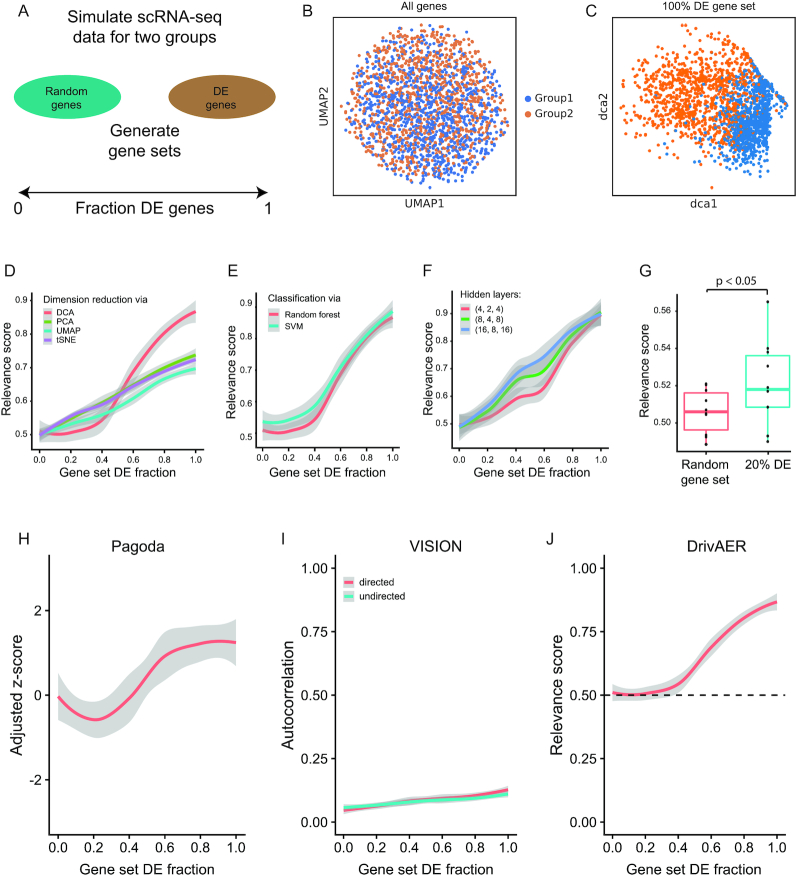
DrivAER identifies drivers underlying subtle transcriptional changes. (A) Two groups of single cells were simulated and gene sets were created by sampling a mixture of truly differentially expressed (DE) genes and random genes. (B) The global embedding using all genes is visualized using UMAP. (C) The DCA embedding for a gene set consisting of all truly DE genes is depicted. For both (B) and (C), cells are colored by group. (D) Relevance scores (y-axis) for gene sets ranging in the fraction of truly DE genes (x-axis) are displayed across implementations of DrivAER differing in the underlying dimension reduction methods. (E) Relevance scores (y-axis) for gene sets ranging in the fraction of truly DE genes (x-axis) are displayed using random forest (red) and support vector machine (SVM; blue) classification models. (F) Relevance scores (y-axis) for gene sets ranging in the fraction of truly DE genes (x-axis) are displayed across various configurations of the hidden layer. (G) Box plot shows significantly different relevance scores between 10 bootstrap runs of completely random gene sets (red) and gene sets consisting of 20% truly DE genes (blue) (1-sided t-test, P = 0.0467). The boxes represent the interquartile range, the horizontal line in the box is the median, and the whiskers represent 1.5 times the interquartile range. (H) PAGODA's adjusted z-scores (y-axis) are displayed for gene sets ranging in the fraction of truly DE genes (x-axis). (I) VISION's autocorrelation statistic is displayed for gene sets ranging in the fraction of truly DE genes (x-axis). (J) DrivAER (default parameters) relevance scores (y-axis) are displayed for gene sets ranging in the fraction of truly DE genes (x-axis). The horizontal dashed line indicates 0.5, the accuracy of random guesses for a binary outcome. For (D), (E), (F), (H), (I), and (J) lines represent the smoothed values and gray shading represents the 95% confidence interval derived from the smoothing fit.